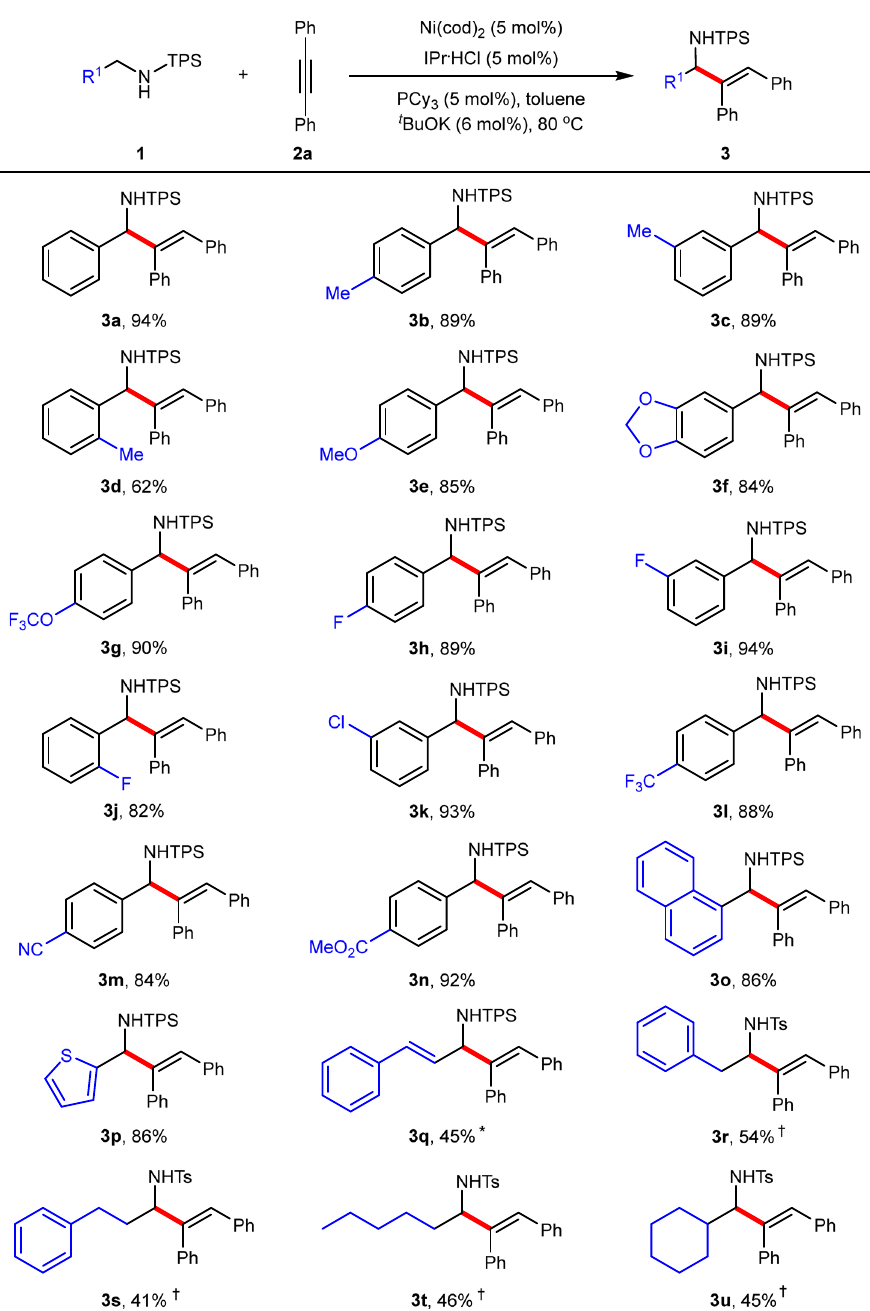
Fig. 3 Scope of amines. Reaction conditions: 1 (0.20 mmol), 2a (0.22 mmol), toluene (2.0 mL) under N 2 for 1 − 12 h; yield of isolated products. * Ni(cod) 2 (10 mol%), IPr·HCl (10 mol%), PCy 3 (10 mol%), t BuOK (12 mol%) at 110 °C. † Ni(cod) 2 (20 mol%), IMes·HCl (20 mol%), PCy 3 (20 mol%), t BuOK (22 mol %) at 130 °C. Ts =